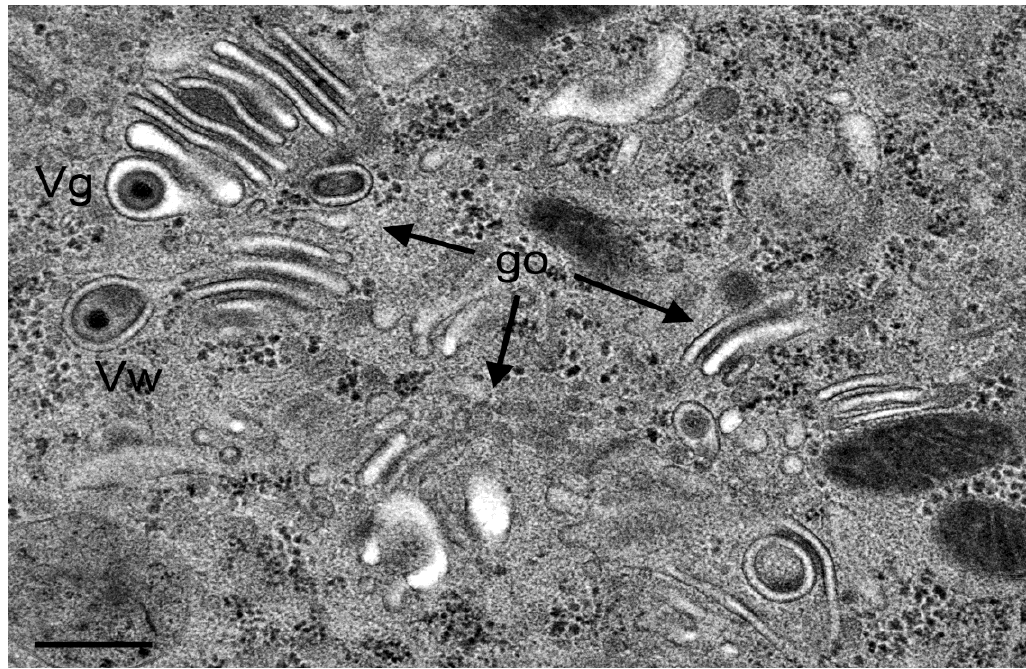
Figure 11. TEM images of three Golgi fields (go) containing thick electron dense membranes at 24 hpi with R7041(∆U S 3). One virion has probably entered the cisterna by budding or via intraluminal transportation (Vg), the other virions has been probably derived by wrapping (Vw). Note the difference in electron density of the space between viral envelope and vacuolar membrane. Bar = 500